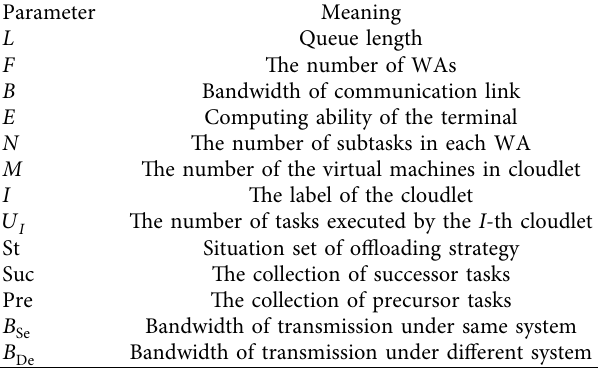
Table 1: Key terms and